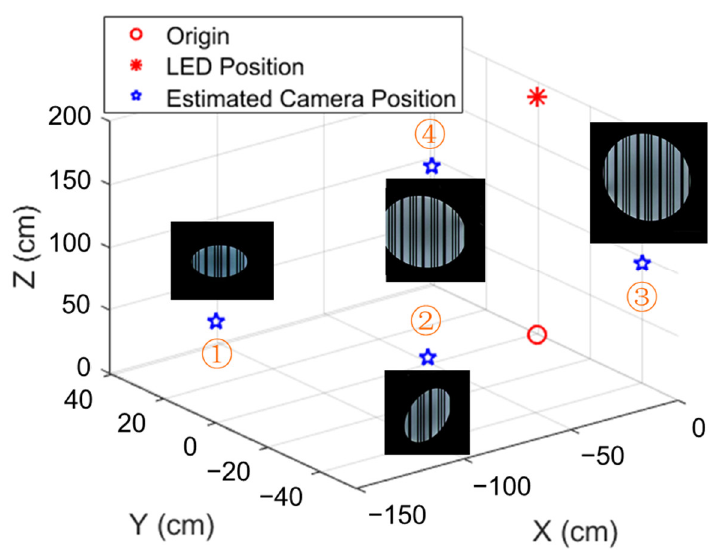
Figure 11. Measured 3D world coordinates of camera with images captured at four positions.